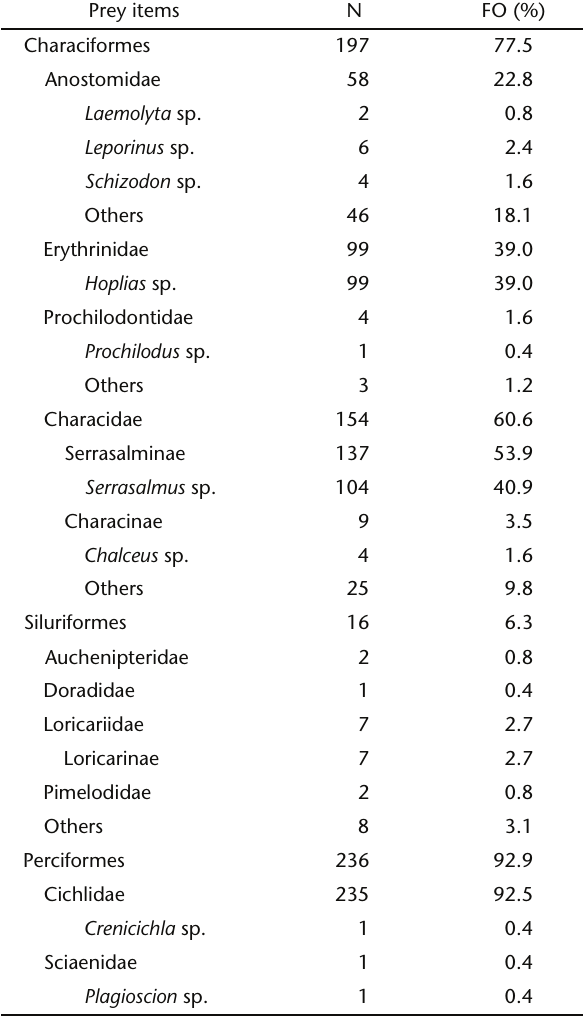
Table I. Frequency of occurrence (FO) of the fish groups identified in a total of 254 feces samples of giant otters from Balbina hydroelectric